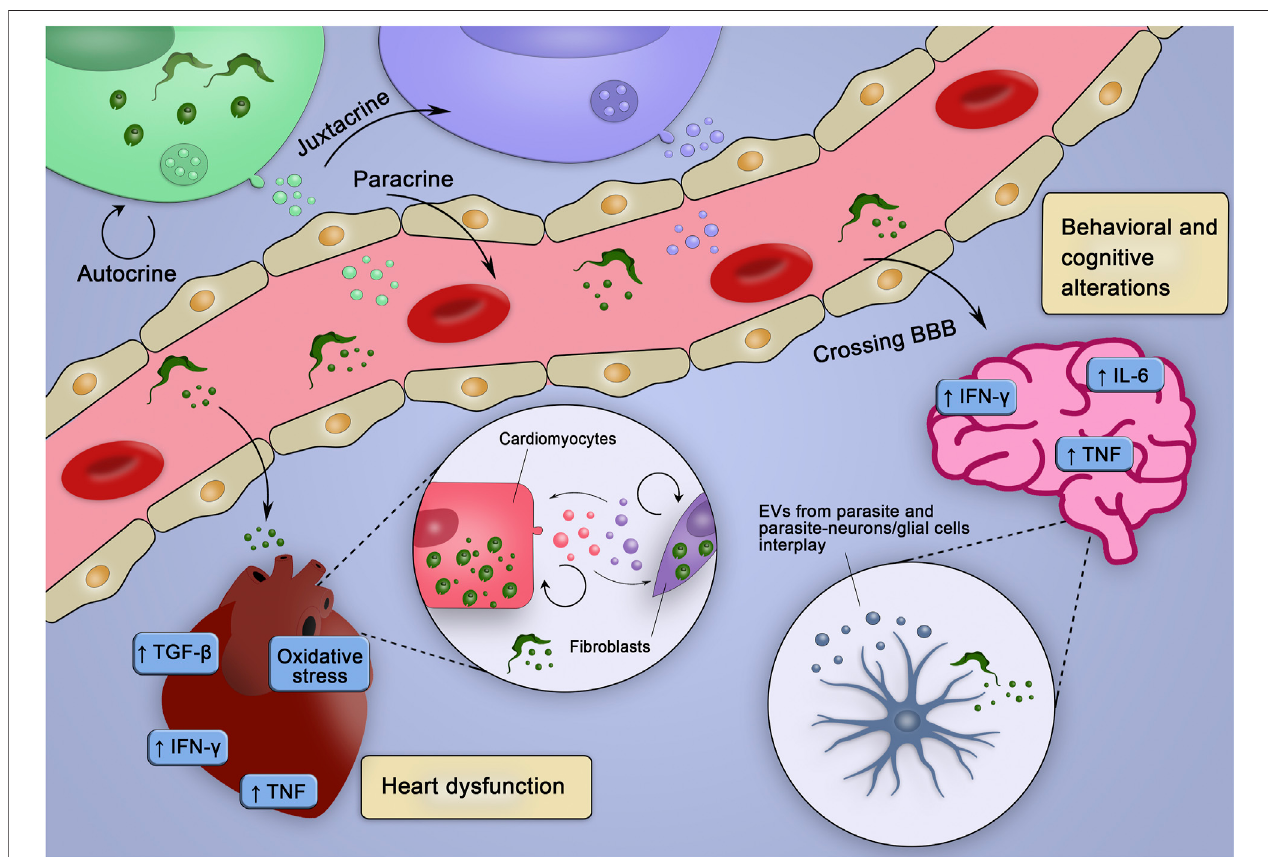
FIGURE3| HypotheticalintegrativeviewoftheeffectsofvarioussourcesofEVinthepathogenesisofCD.EVsofdistinctoriginsmayactinanautocrine,juxtracrine, and/orparacrineway,contributingtocreatein fl ammatorymilieu(enrichedinin fl ammatorycytokinesandmediators),whichmaytriggertissue-speci fi cinjurymechanisms leading to heart dysfunction and behavioral and cognitive alterations. EVs from parasite and infected cells could cross the blood-brain barrier (BBB), interact with neurons/glial cells and stimulate the production of cytokines and co-stimulatory molecules already related to behavioral and cognitive alterations. Alternatively, parasites could cross the BBB and infect glial cells, which could release EVs and affect surrounding cells. In the heart, EVs from the parasite could, at fi rst, reduce the production of molecules that would fi ght the parasite and favor the establishment of the infection. Posteriorly, the EVs from infected cells could sustain the in fl ammatory pro fi le observed during chronic infection contributing to the heart